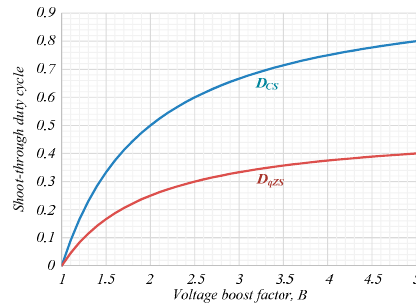
Figure 10. Dependences of the ST duty cycles on the input voltage boost factor.